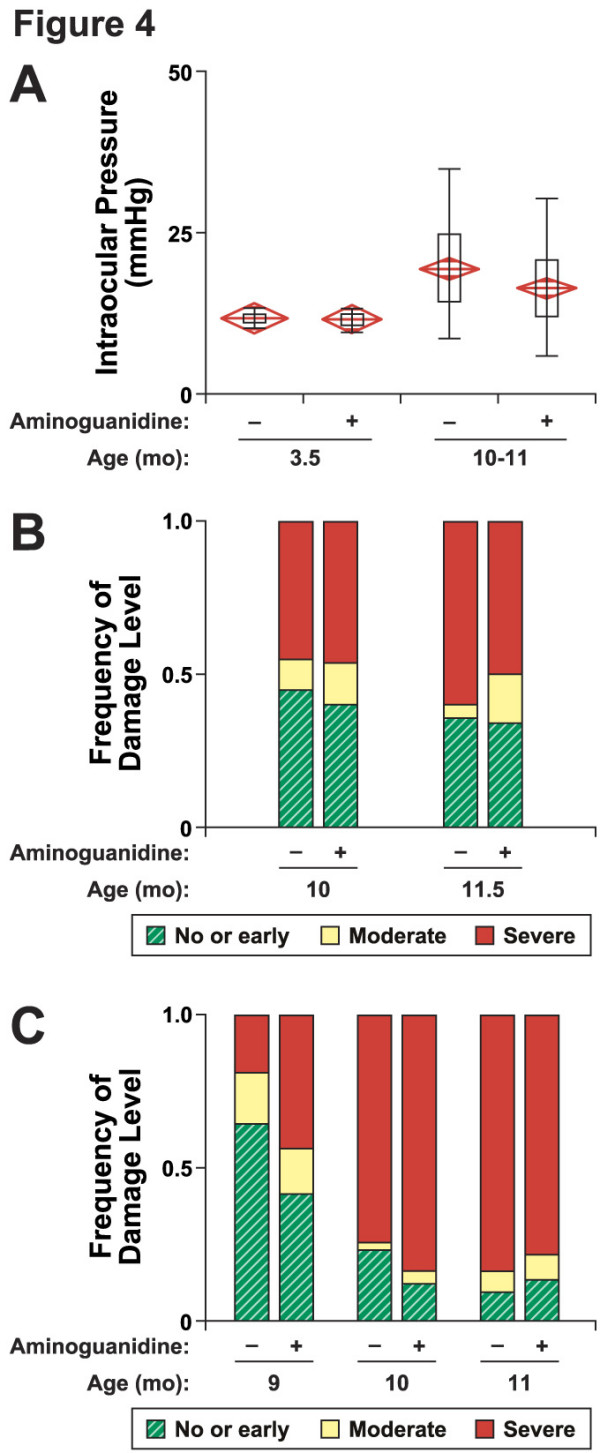
Aminoguanidine treatment does not alter IOP or glaucomatous neurodegeneration. (A) Ag-treatment did not affect the pre-glaucomatous IOP of DBA/2J mice (3.5 months: average mmHg ± s.e.m., number of eyes examined; control 11.8 ± 0.2, 19; Ag-treated 11.7 ± 0.2, 23; P = 0.76). Ag-treatment did not affect the ocular hypertension during the key window in disease progression, between 10 and 11 months (control, 18.2 ± 1.0, 31; Ag-treatment, 16.6 ± 1.3, 30; P = 0.334). (B) Ag-treatment from 5 months of age does not alter glaucomatous neurodegeneration (given as total number analyzed, treatment group, number of that treatment with mild, moderate, severe glaucoma) 10 months, 51 controls, 22,6,23; 51 Ag-treated 21,6,25; P = 0.293; 11.5 months, 55 controls, 18,6,31; 46 Ag-treated, 16,7,23, P = 0.896. (C) Ag-treatment beginning at 3 months of age does not protect from glaucomatous neurodegeneration. Nine months old treated mice actually tended to have more severe damage (given as total number analyzed, treatment group, number of that treatment with mild, moderate, severe glaucoma) 9 months, 42 controls, 27,7,8; 41 Ag-treated 17,6,18; P = 0.04; 10 months, 43 controls, 10,1,32; 49 Ag-treated, 6,2,41, P = 0.4; 11 months, 43 controls, 4,3,36; 37 Ag-treated, 5,3,29, P = 0.8. The experiments shown in B and C were performed at different institutions (see text).